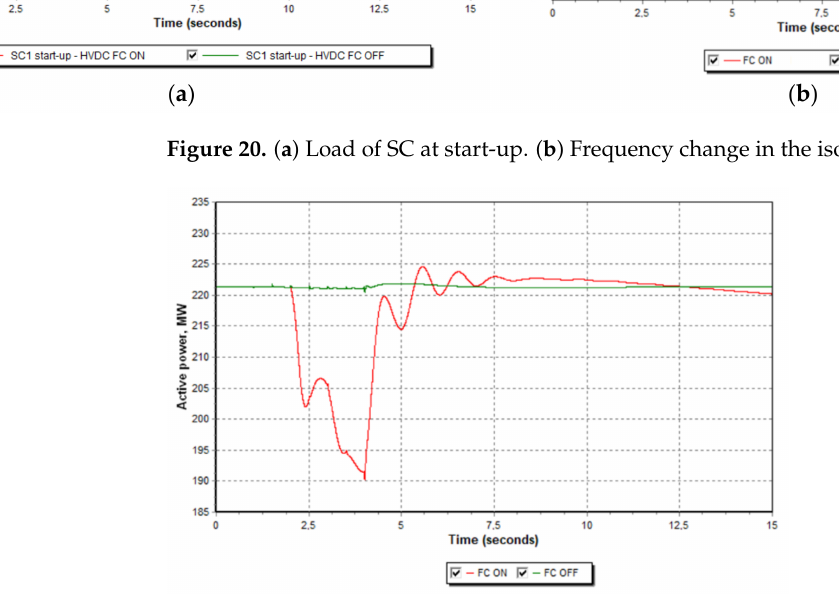
Figure 21. Response of the HVDC BtB converter to SC activation